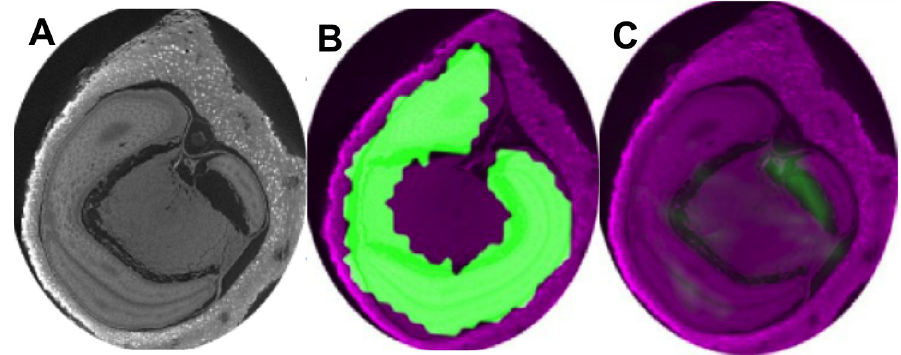
Figure 5. ( A ) X-ray tomography used as a reference map; ( B ) registration of MRI lipid-contrasted images (in green) with X-ray tomography (in purple) images; ( C ) registration of MRI water-contrasted images (in green) with X-ray tomography (in purple) images. We first register the lipid content from the embryo of the dry seed in MRI with the tomography image, as the embryo shape and orientation are recognizable at the spatial resolution of MRI images. After registration, it gives us the transformations we need to apply to water MRI images to be registered with the anatomy of the seed identified by X-ray tomography. Table 1. Specificities of the four non-invasive imaging techniques reviewed in this